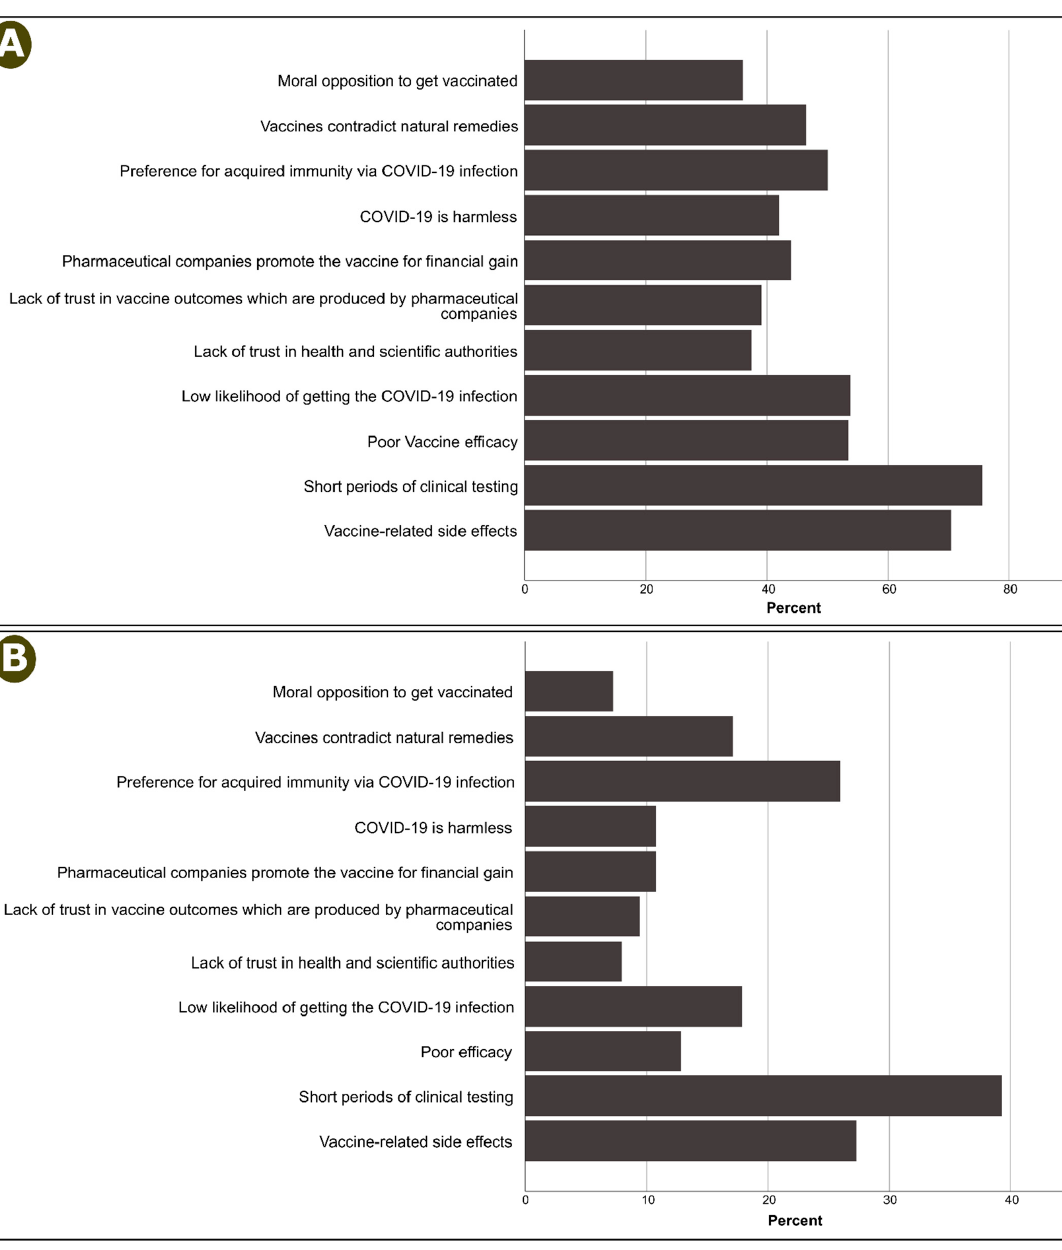
Figure 1. Reasons for hesitancy among participants who answered ( A ) no or ( B ) unsure regarding their intention to get vaccinated.